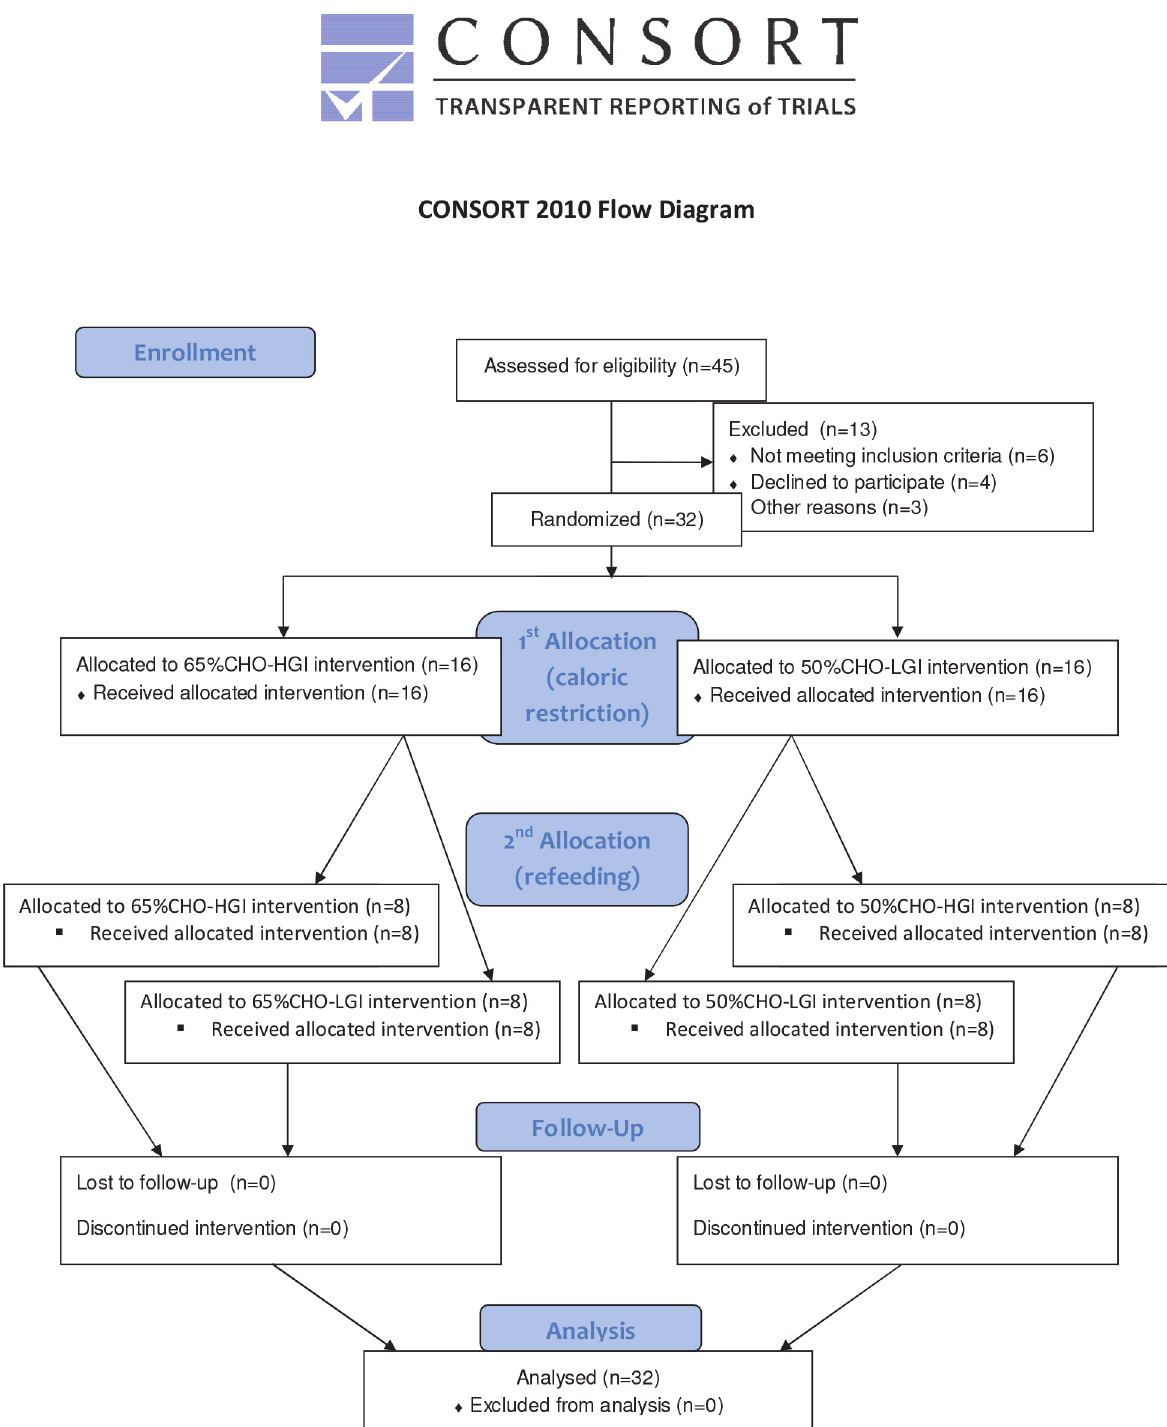
Fig 1. CONSORT flow chart, showing the passage of participants through the different stages of the present trial: enrollment, first allocation after OF to the 65%CHO and 50%CHO intervention and second allocation after CR to 65%CHO-HGI, 65%CHO-LGI, 50%CHO-HGI and 50%CHO-LGI intervention, follow-up, and analysis. OF, overfeeding; CR, caloric restriction; CHO: carbohydrate, HGI, high glyceamic index; LGI, low glyceamic index